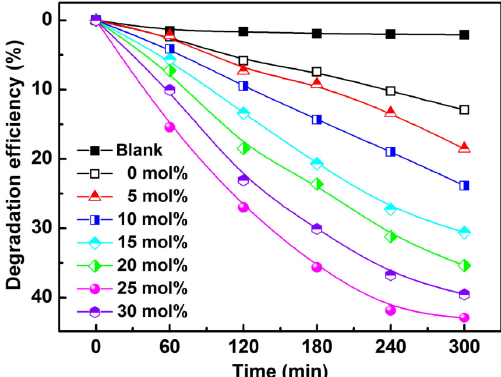
Fig. 7 Degradation rate of RhB using the Ag x /BTO thin films under UV–Vis light.